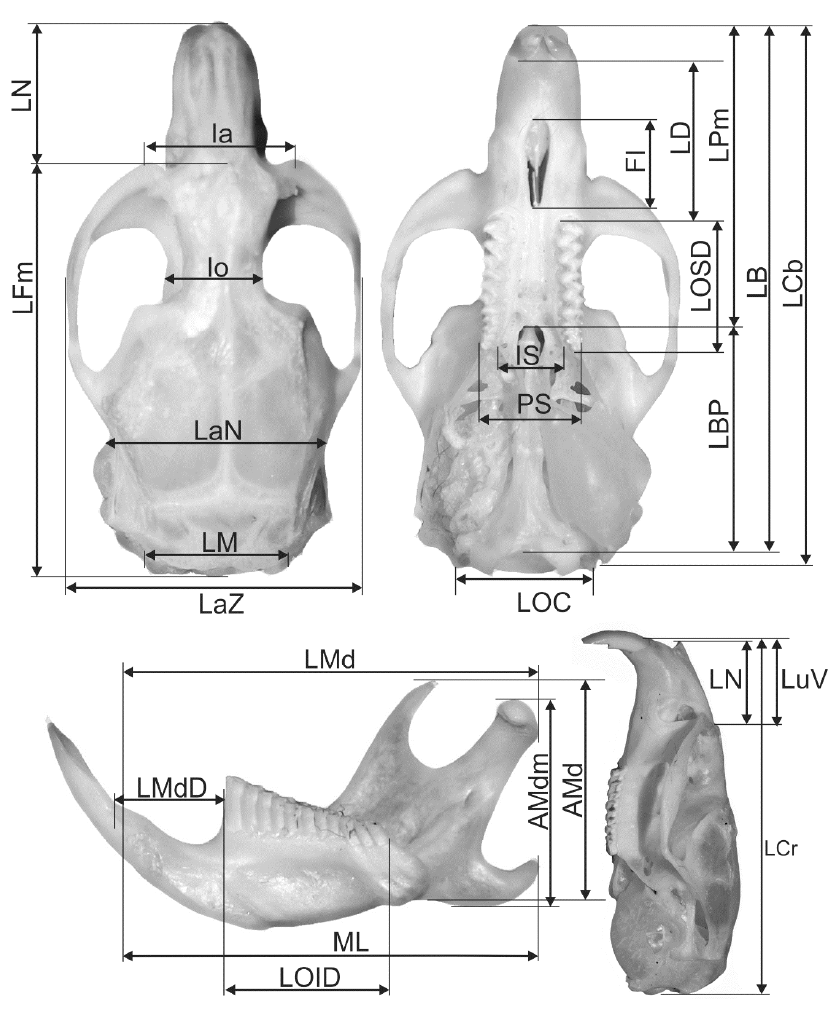
Figure 2. Measured skull and lower jaw dimensions of Pannonian root vole.